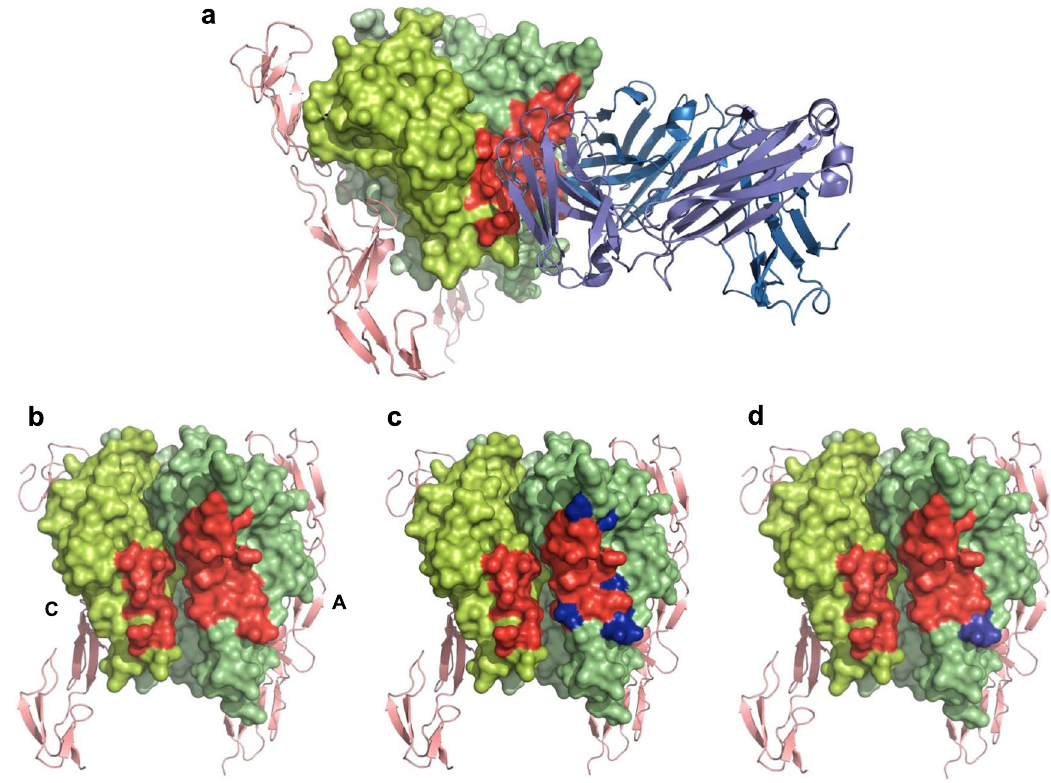
Fig. 5 Detail of the epitope of CA1974 Fab. a Complex of human TNF (green surface rendered), CA1974 Fab (blue ribbons), and human TNFR1 (pink ribbons) with epitope residues highlighted in red. b Head-on view of the CA1974 Fab epitope spanning monomers A & C on human TNF (highlighted in red). For clarity CA1974 Fab has been removed and monomers A and C have been labelled. c CA1974 Fab epitope with residues that vary in mouse TNF marked in blue. d Equivalent view with residues that vary in cynomolgus monkey TNF marked in blue. Residues that vary between the species are highlighted in Supplementary Table 2.